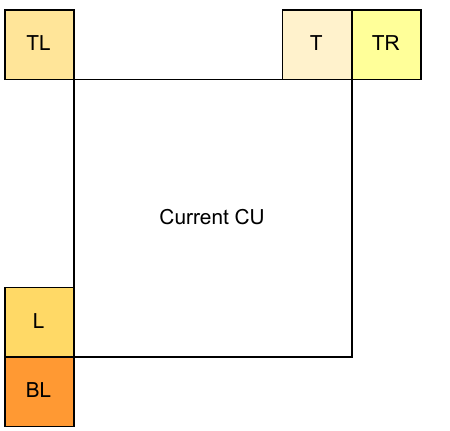
Figure 2. Illustration of location between the current CU and neighbouring